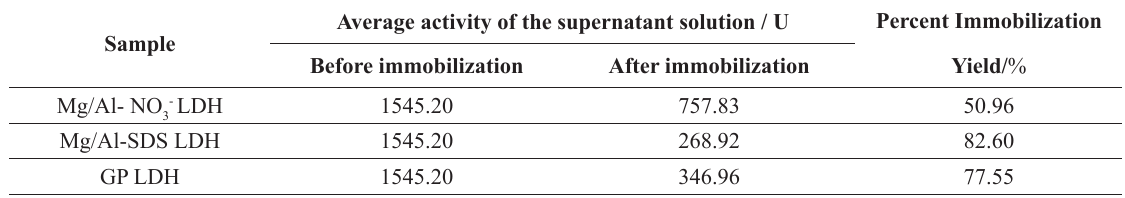
Table 1: Summary of percent immobilization yield